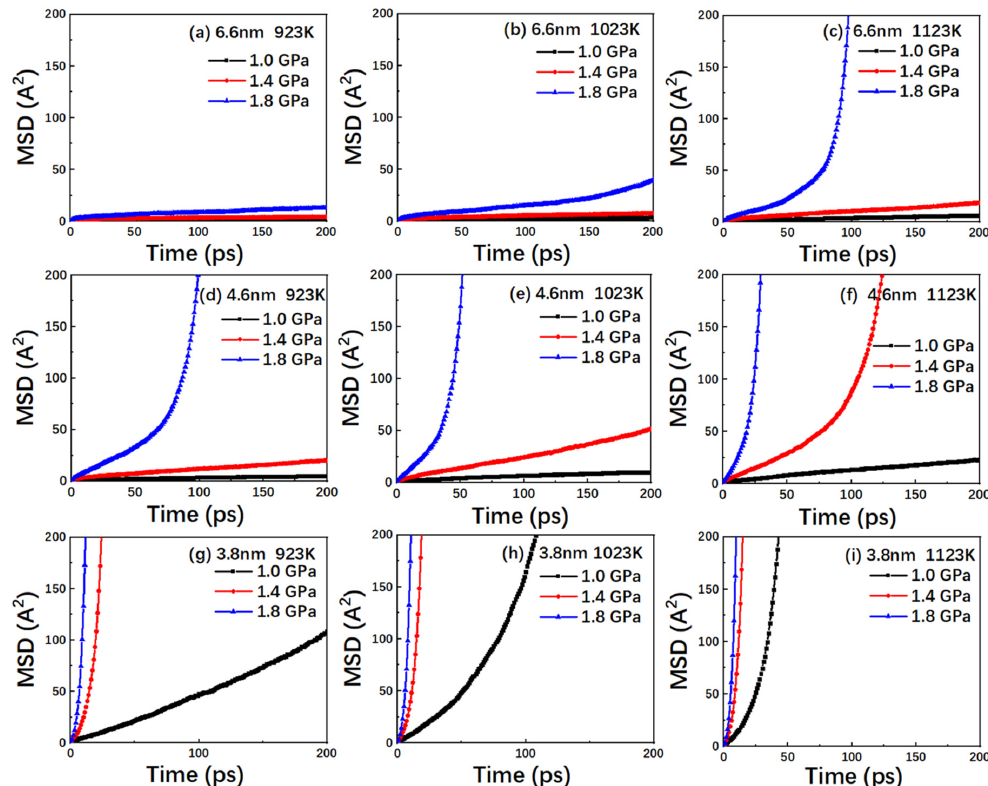
Figure 6. Plots of the MSD versus time for the nanocrystalline TiAl models with grain sizes of ( a ) 6.6 nm at 923 K; ( b ) 6.6 nm at 1023 K; ( c ) 6.6 nm at 1123 K; ( d ) 4.6 nm at 923 K; ( e ) 4.6 nm at 1023 K; ( f ) 4.6 nm at 1123 K; ( g ) 3.8 nm at 923 K; ( h ) 3.8 nm at 1023 K; and ( i ) 3.8 nm at 1123 K under the stress levels of 1.0, 1.4, and 1.8 GPa.